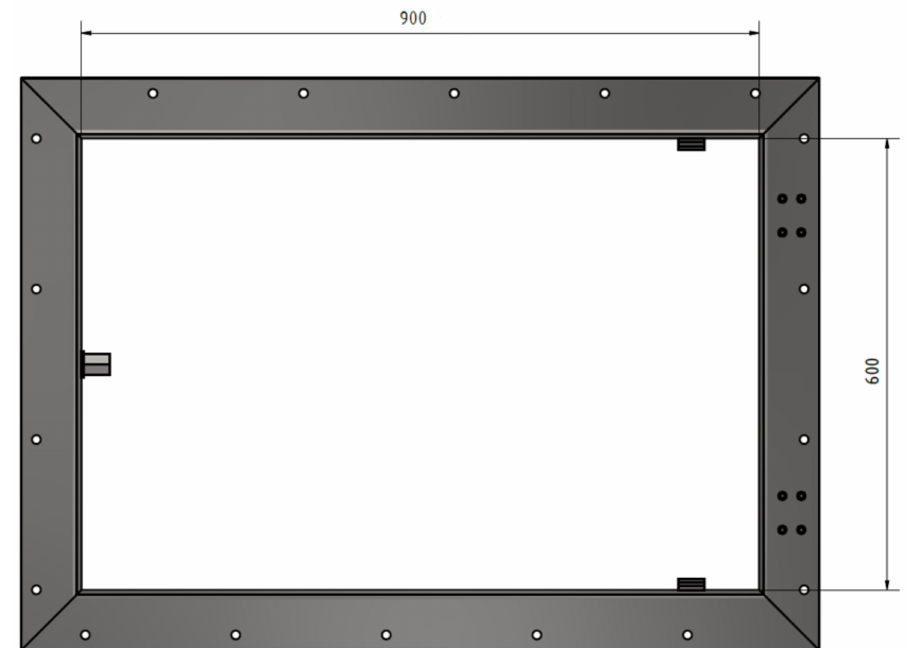
Figure 2. Dimensions of the hatch frame.